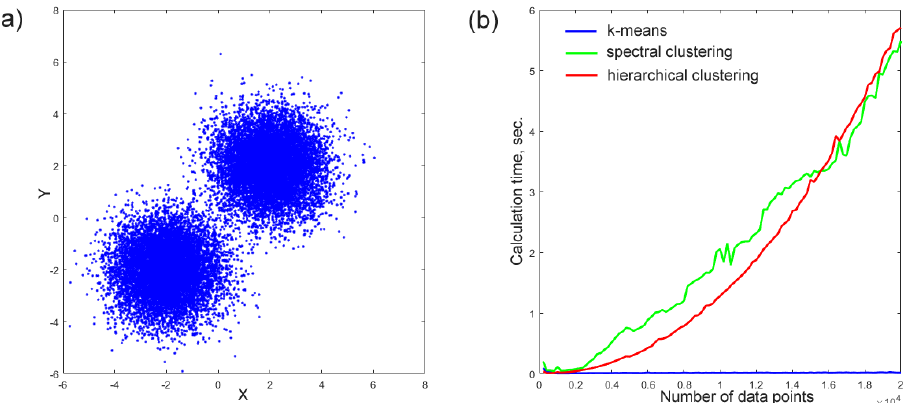
Figure 5. Evaluation of algorithmic performance of conventional clustering techniques including k- means, spectral and hierarchical clustering using synthetic data: ( a ) visualization of a 2D bi-Gaussian distributed point cloud, ( b ) plot of the calculation time of three clustering methods as a function of the data size in the range of n ∈ [ 4 e + 2,4 e + 4 ] data points. Significantly higher algorithmic complexity of spectral and hierarchical clustering algorithms makes their application to megapixel large images